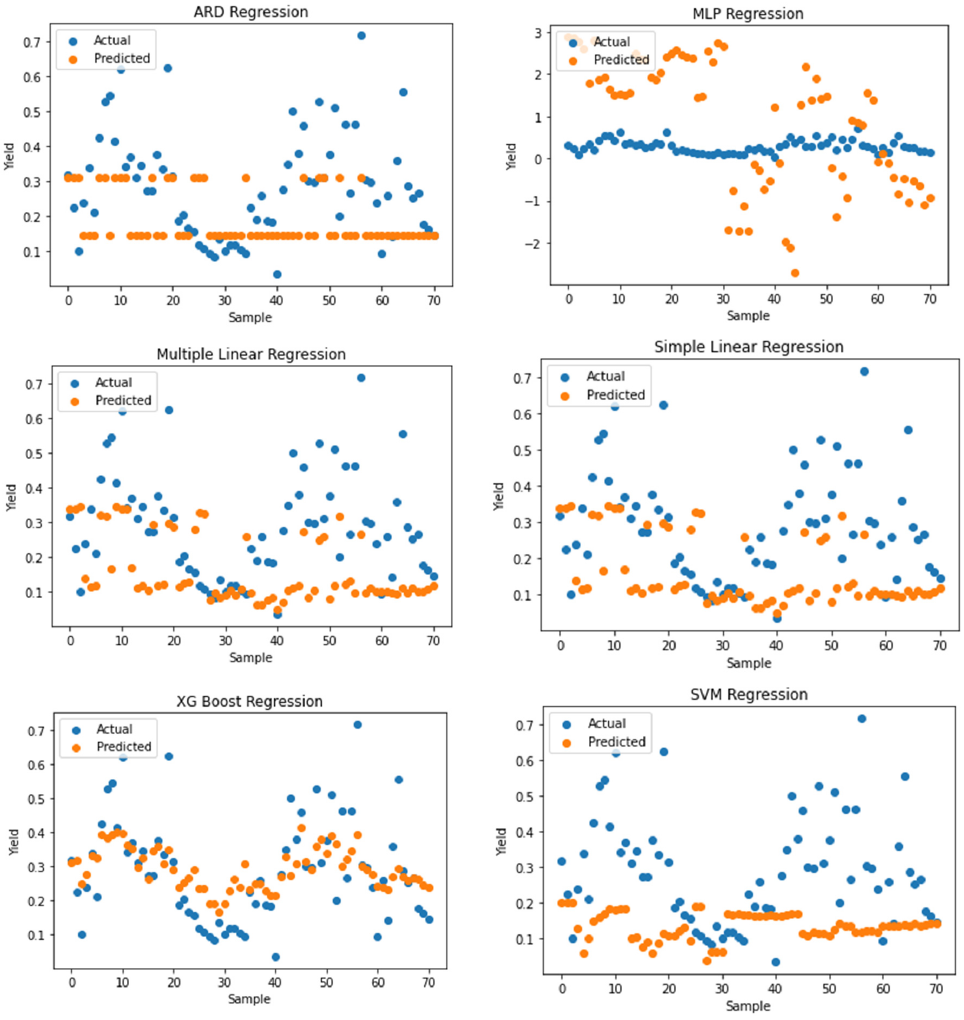
Figure 7. Scatter plots showing actual and predicted yields of all regression algorithms.